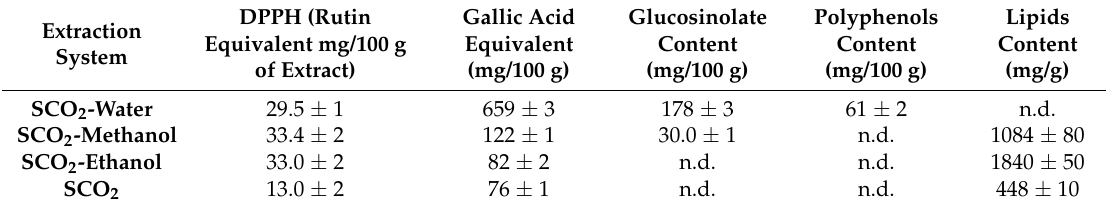
Table 7. DPPH test results compared with amount of Eruca sativa constituents in extracts obtained with SCO 2 at 30 MPa and 45 ◦ C using different co-solvents.